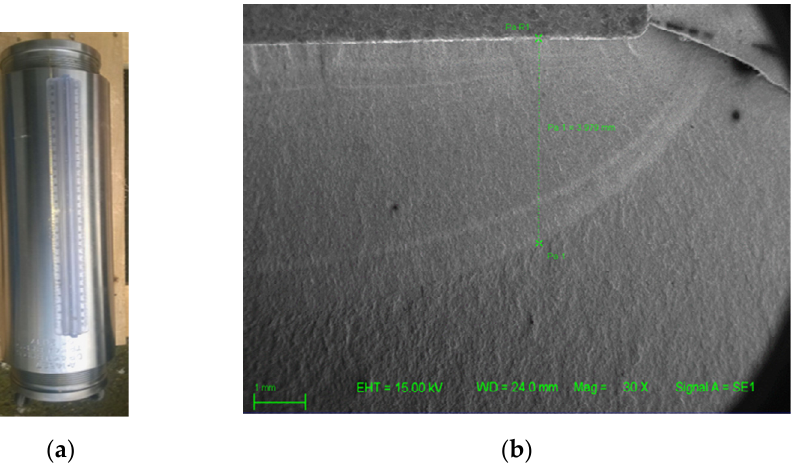
Figure 8. ( a ) AISI 4145 Vessel; ( b ) SEM micrograph of the fracture zone—fatigue test in H 2 .